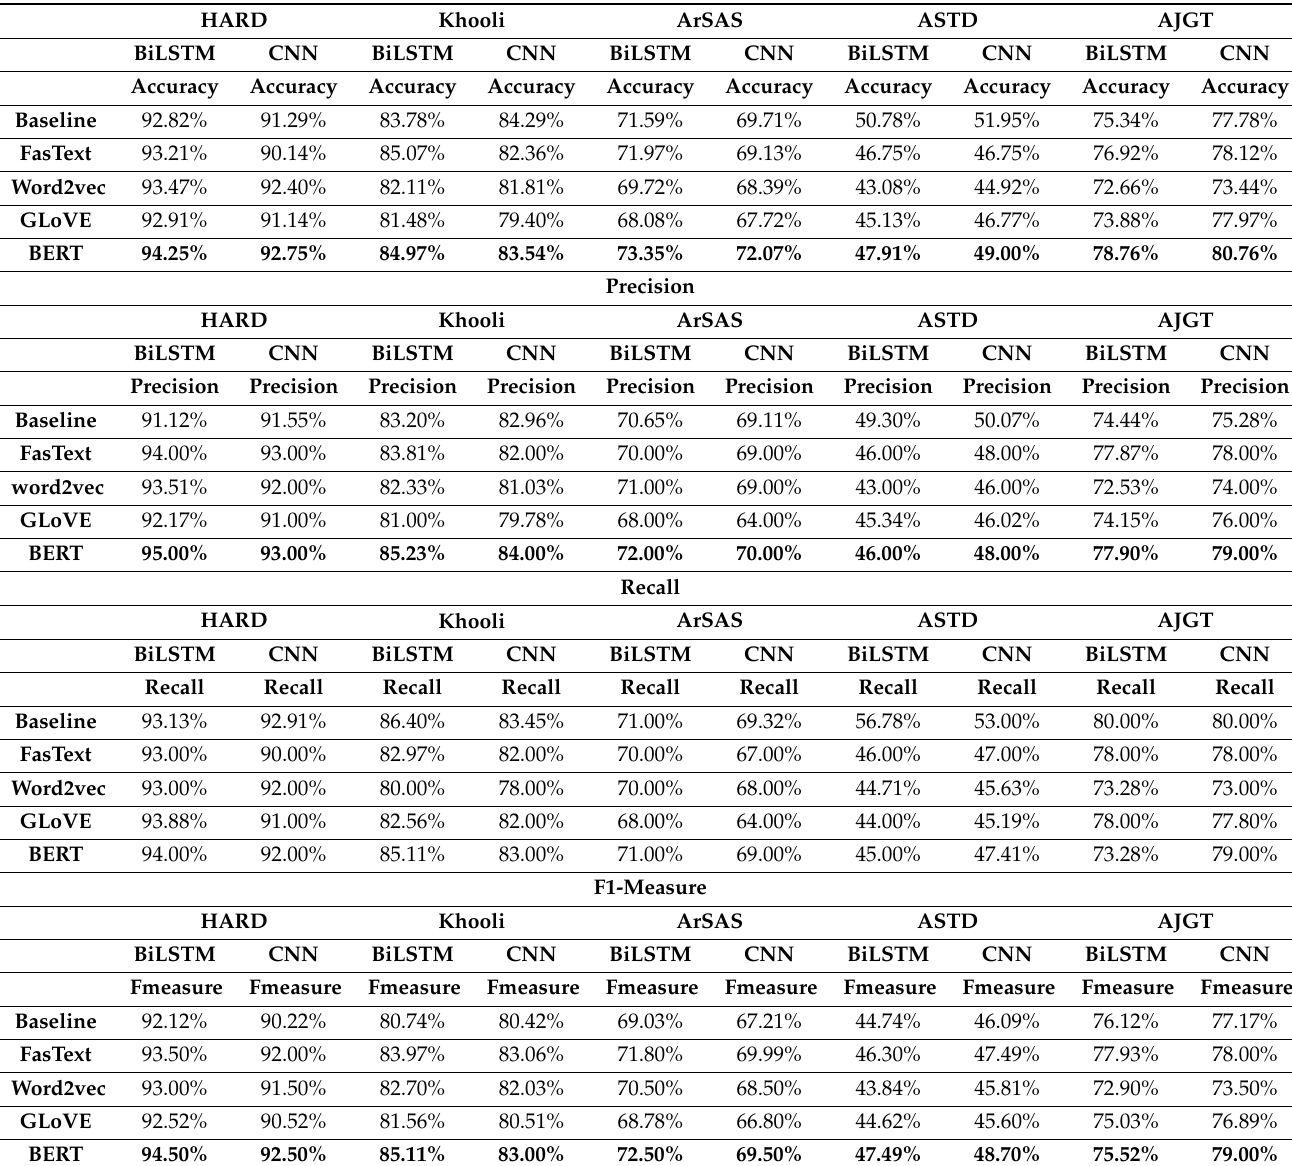
Table 6. Training embeddings